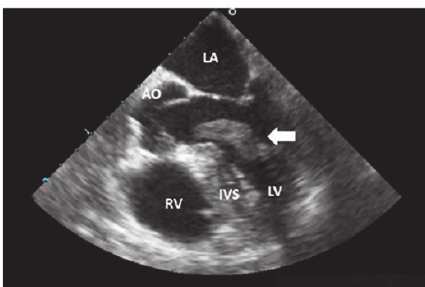
Figure 1: Large mass in the left ventricle (white arrow) extending into the left ventricular outflow tract. AO = aortic root; IVS = interventricular septum; LA = left atrium; LV = left ventricle; RV= right ventricle.